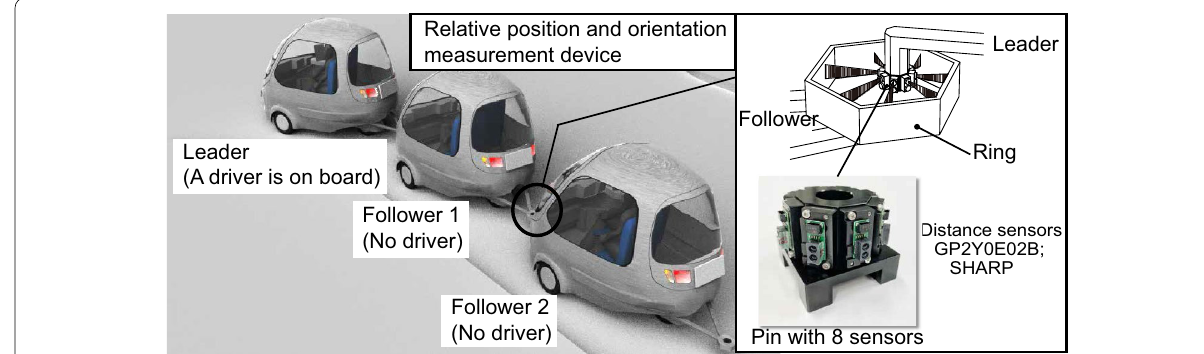
Fig. 1 Overview of proposed platooning system